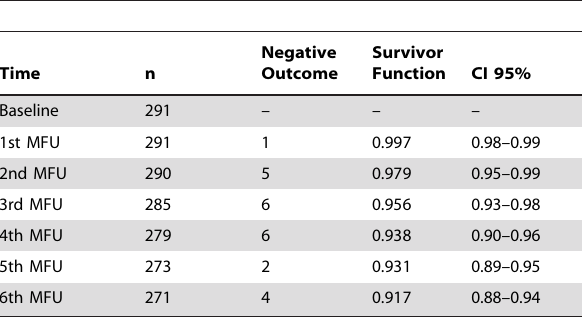
Table 2. Survivor function (SF) for Negative Outcomes (NO) on TB